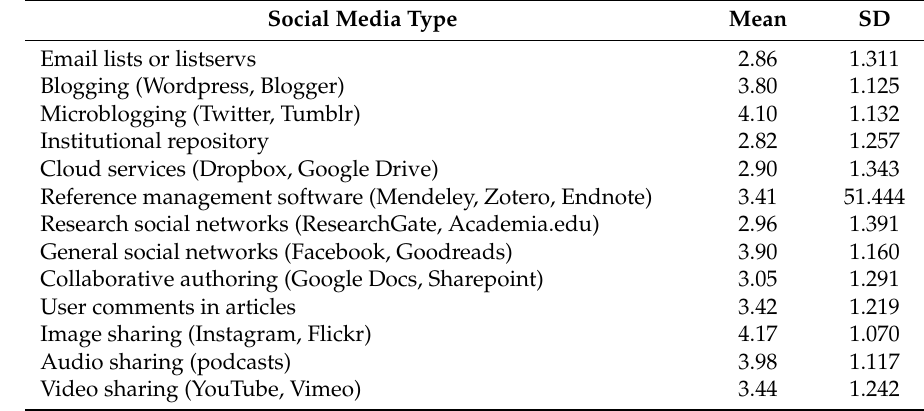
Table 31. Importance of social media platforms to respondents’ work (1 = absolutely essential, 2 = very important, 3 = important, 4 = somewhat important, 5 = not at all